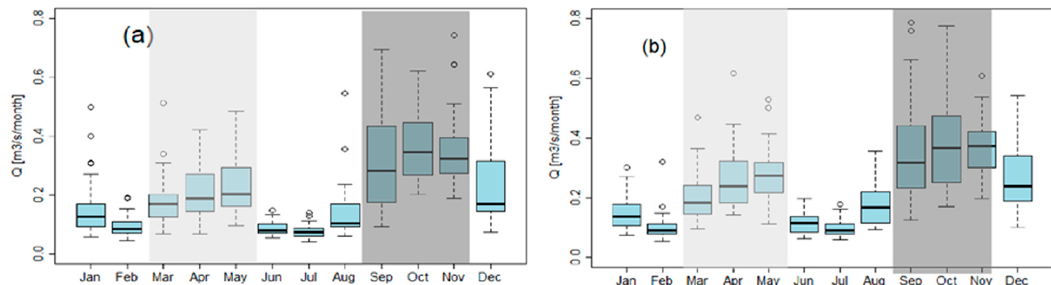
Figure 9. Box plots for the projected monthly average discharges under climate scenarios RCP4.5 ( a ) and RCP8.5 ( b ). Shaded area represents wet seasons (long and short rains) and unshaded area represents dry seasons.